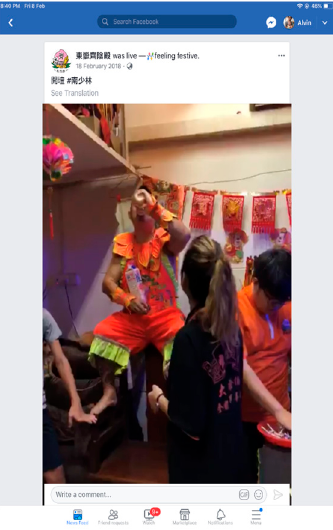
Figure 10. Example of a Temple Pushing Live Videos of Spirit Possession to Followers on Facebook. (Source: Facebook).